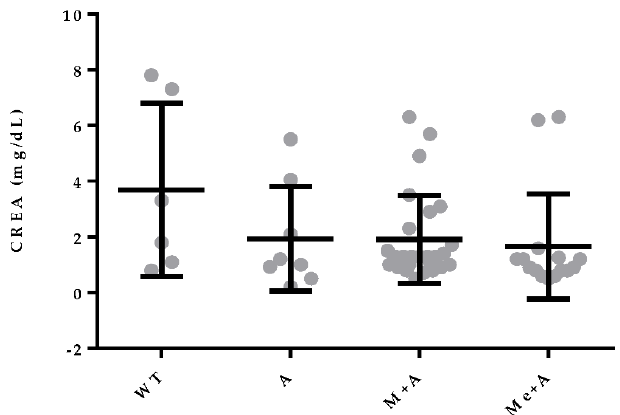
Figure 7. Selection of therapeutic protocol according to blood creatinine levels. Levels of creatinine presented by dogs at the time of CanL diagnosis that were not treated (WT), treated with allopurinol alone (A), miltefosine plus allopurinol (M + A) or meglumine antimoniate plus allopurinol (Me + A) represented by mean and standard deviation. Only events (death) were considered.